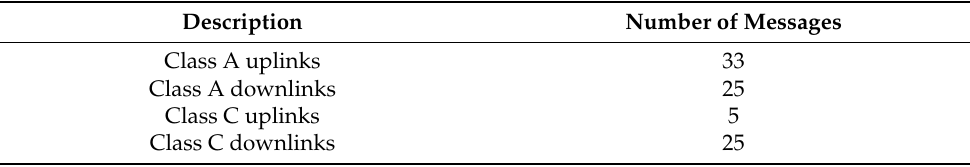
Table 12. Exchanged Number of Messages During 1 kB of Firmware Fragment with